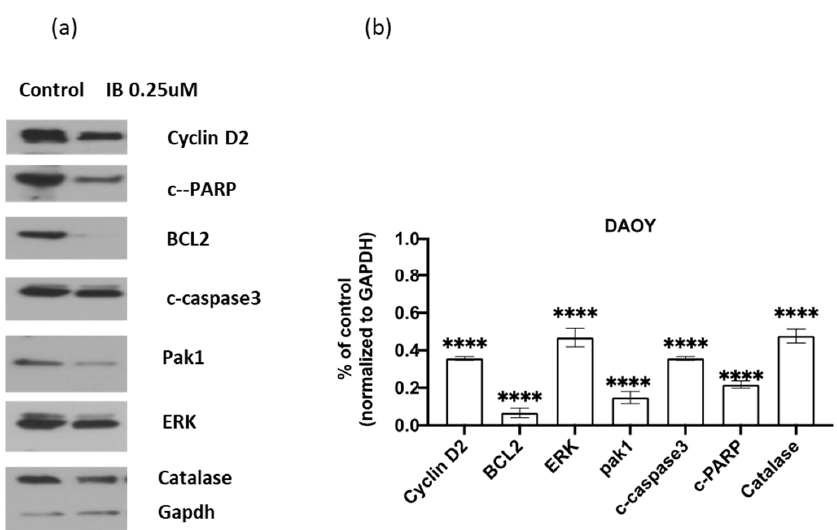
Erk and PAK activation are cardinal features of medulloblastoma aggressiveness and are required for cell migration and invasive behavior [14]. Treatment with nanomolar quantities of IB led to decreased ERK expression, PAK expression, and decreased expres- sion of catalase (Figure 2a). The downregulation of catalase is a biomarker of Nox inhibi- tion, as Nox generated hydrogen peroxide activates catalase. IB kills medulloblastoma cells at 72 h of exposure. Surprisingly, IB treatment did not upregulate PARP cleavage, suggesting that necrosis, rather than apoptosis is the major mode of cell death. We further confirmed that IB causes necrosis through flow cytometric analysis (Figure 2b).